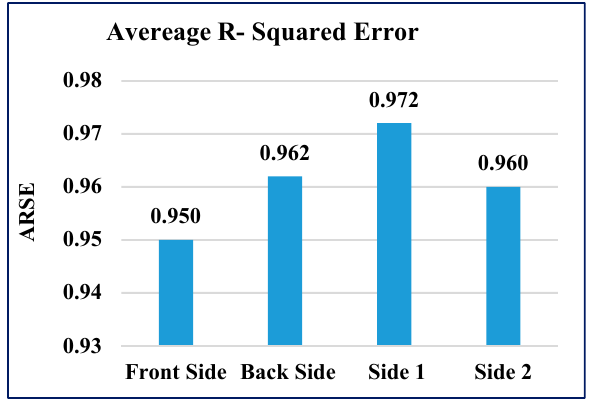
Figure 9. Average R-squared error (ARSE) of GAIN.